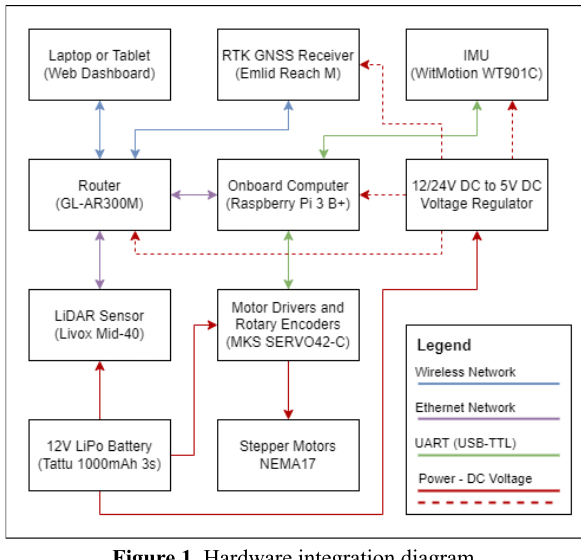
Figure 2. Stepper motors, gears and bearings of yawing and pitching mechanisms highlighted in